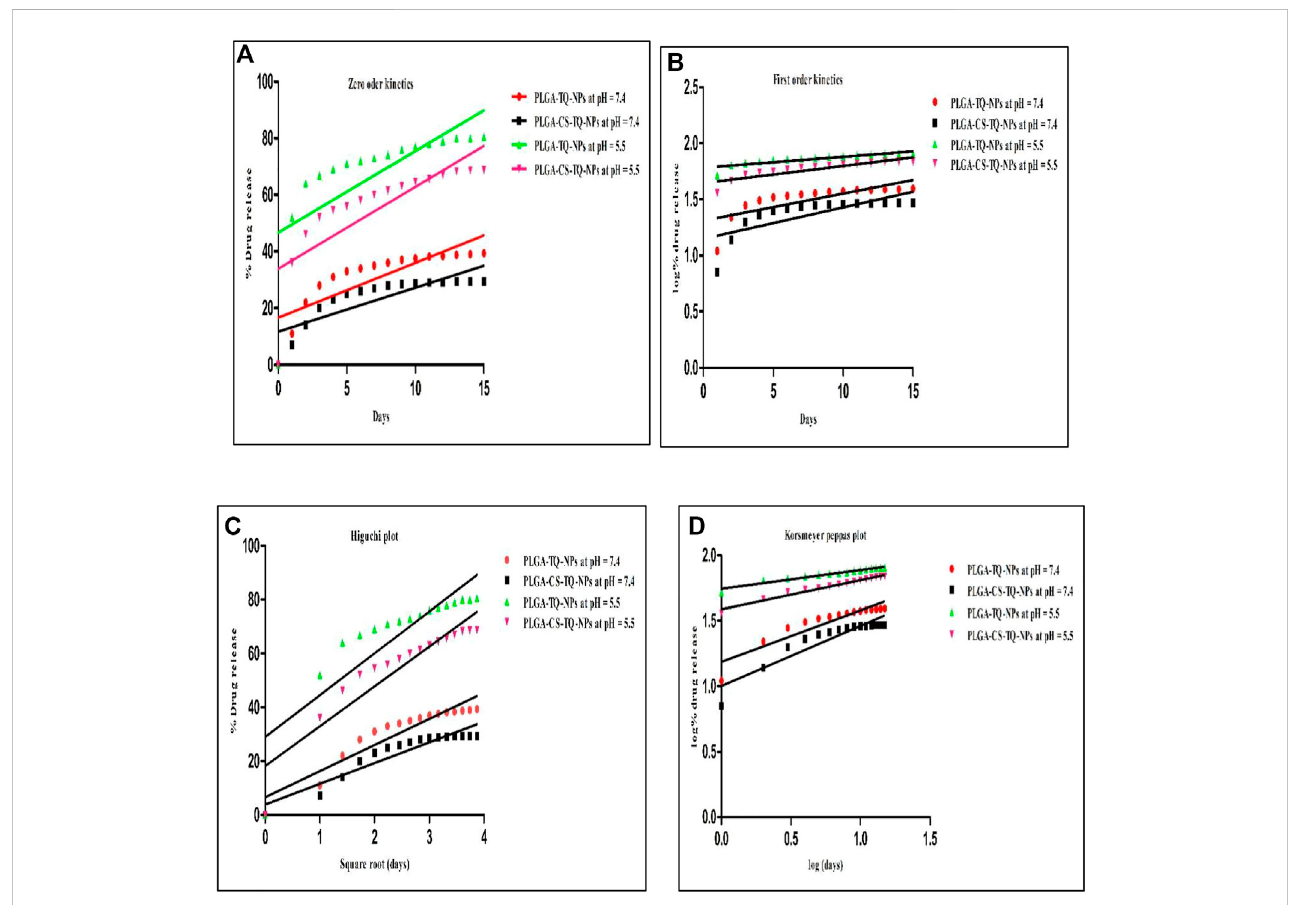
FIGURE 6 Showed different models of release kinetics (A) zero order kinetics model (B) fi rst order kinetics model (C) Higuchi model (D) Korsmeyer Peppas model plot.